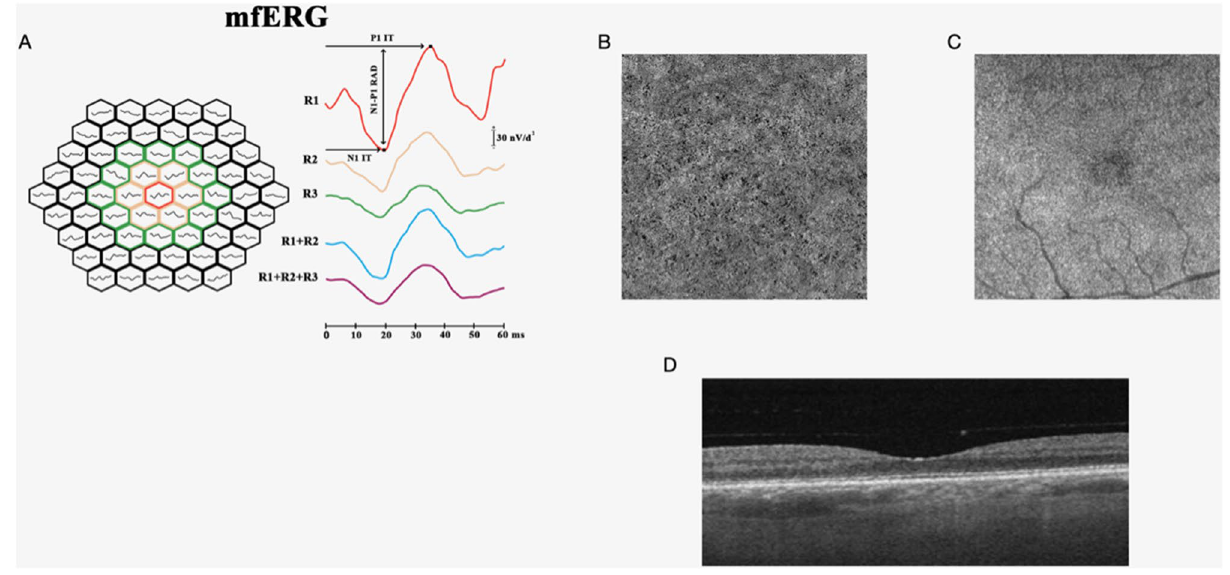
Figure 1. Example of images from one of our patients. ( A ) Multifocal electroretinogram (mfERG) bioelectrical responses in one representative eye affected by non-proliferative diabetic retinopathy (NPDR). The 61 hexagons trace arrays, subtending 15° of visual field, were sub-grouped in concentric annular areas (rings, R). We measured the N1-P1 response amplitude density (RAD) of mfERG responses recorded from three isolated and combined averaged rings with increasing eccentricity from the fovea: 0 to 2.5 (R1), 2.5 to 5 (R2), 5 to 10 (R3), 0 to 5 (R1 + R2), 0 to 15 (R1 + R2 + R3) degrees. ( B ) Choriocapillaris optical coherence tomography angiography (OCTA) slab acquired with PLEX Elite device. Several small regions of signal voids (dark spots scattered throughout the image) are evident on the enface OCTA image of the choriocapillaris and represent regions of decreased perfusion. ( C ) Ellipsoid zone (EZ) OCTA slab acquired with PLEX Elite device. The structural image at the level of the EZ shows regions of reduced reflectivity, which constitutes a surrogate for photoreceptor damage. ( D ) Corresponding structural optical coherence tomography acquired with PLEX Elite device.